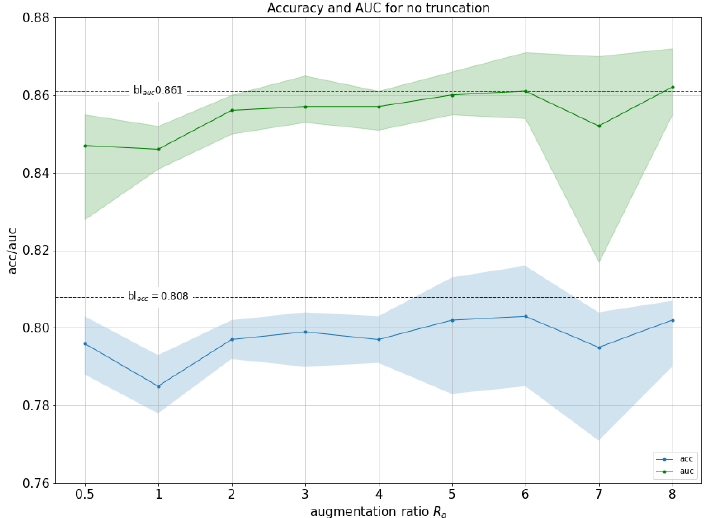
Figure 5. Accuracy (blue, with max and min) and AUC (green, with max and min) for replacement experiments for no truncation. Horizontal lines represent the baseline accuracy and AUC (without GAN data